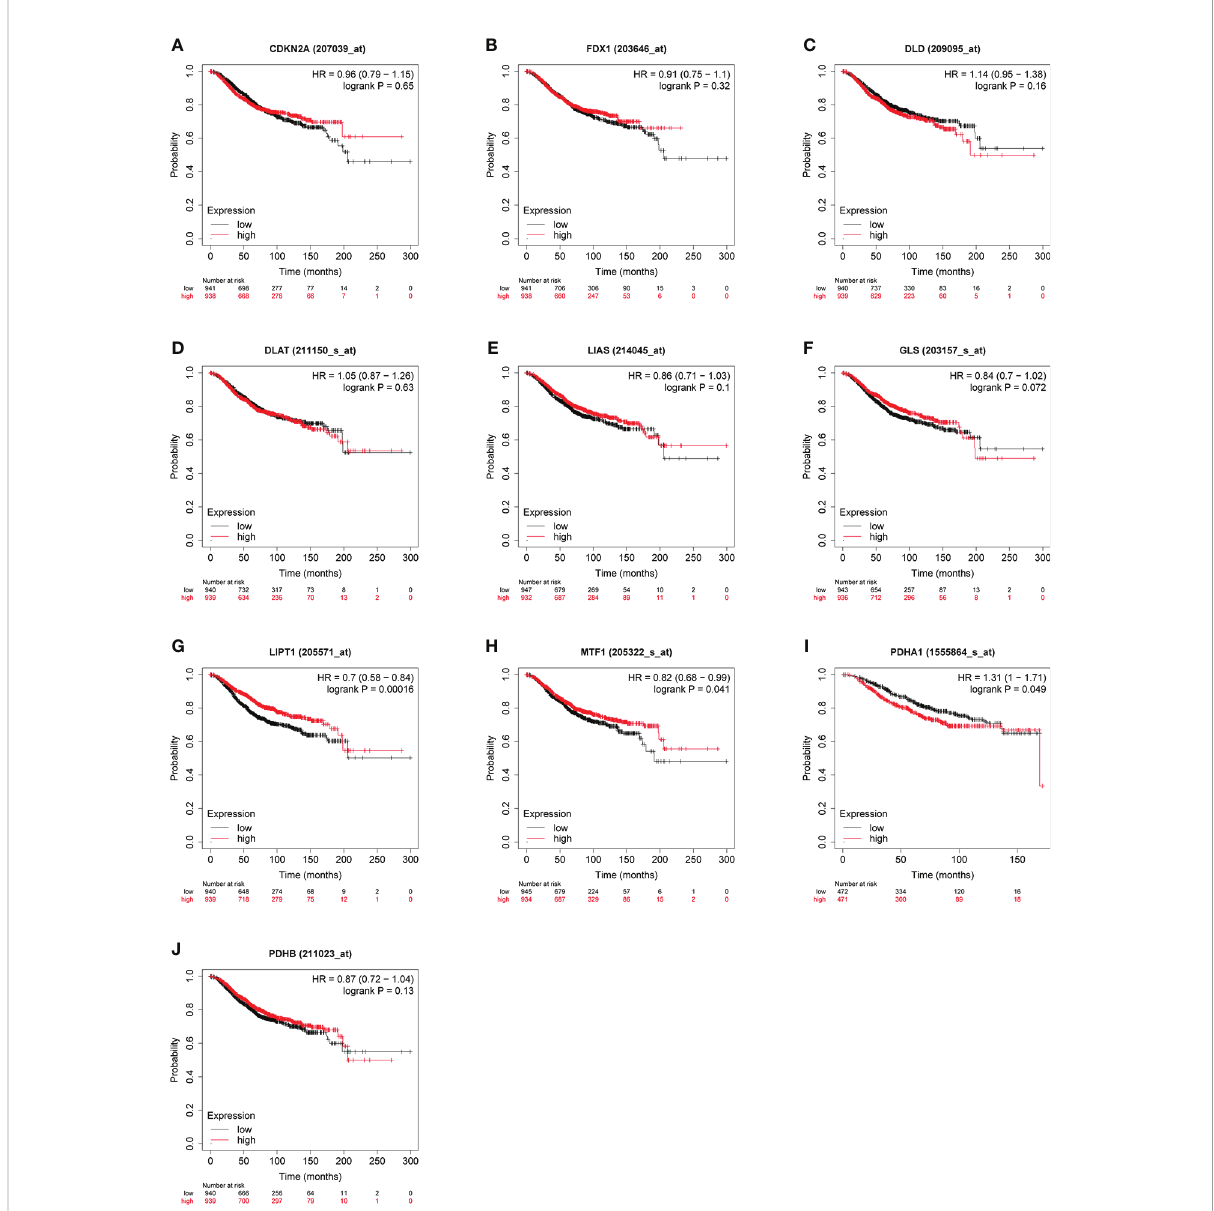
FIGURE 5 Relationship between CRGs (A – J) expression levels and OS in BC. The curves generated by using the KM plotter database show the prognostic value of CRGs. The red lines indicate high CRGs expression, and the black lines indicate low CRGs